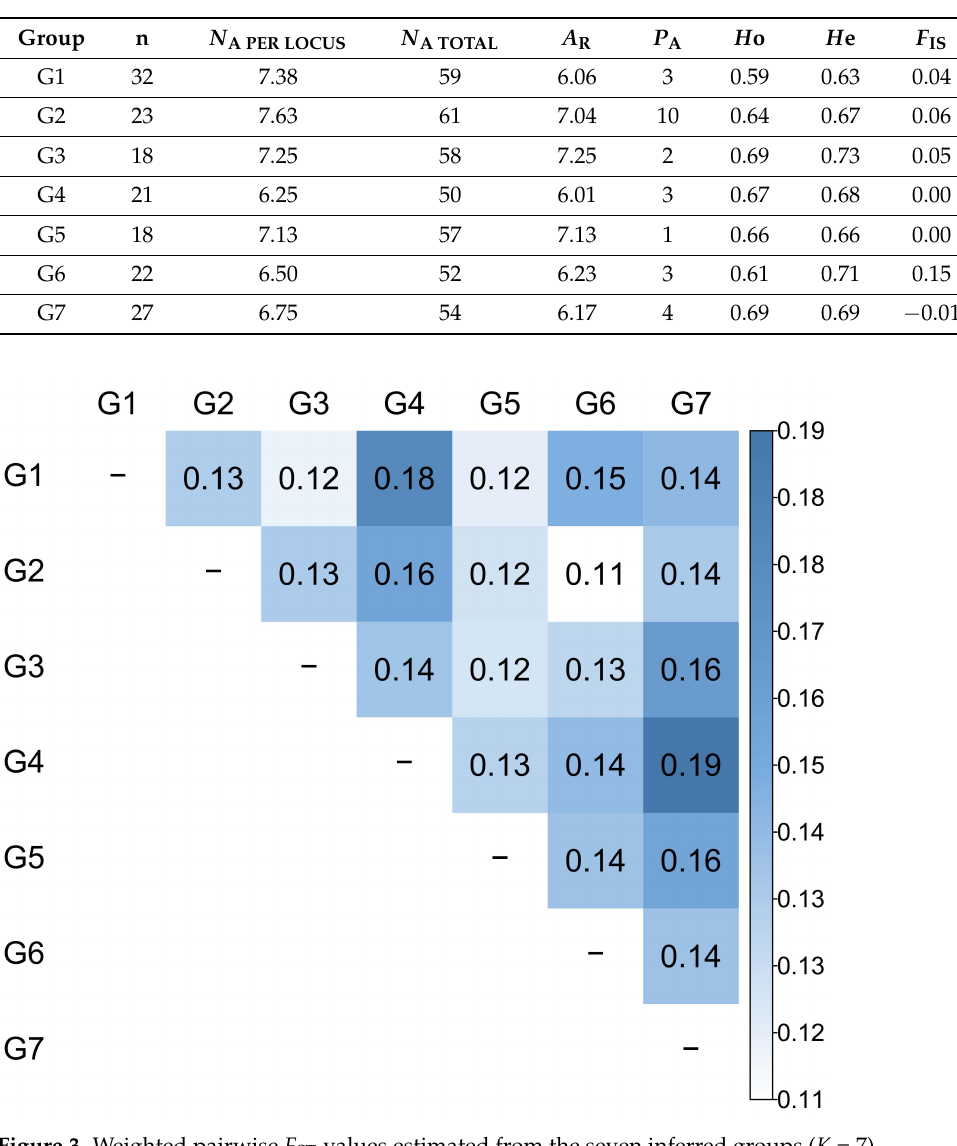
Table 5. Statistics of genetic variation for 161 Japanese plum-type accessions clustered in seven groups. Number of accessions (n), Number of alleles ( N A ), Number of private alleles ( P A ), Allelic richness ( A R ), Observed heterozygosity ( H o), Expected heterozygosity ( H e), Inbreeding coefficient